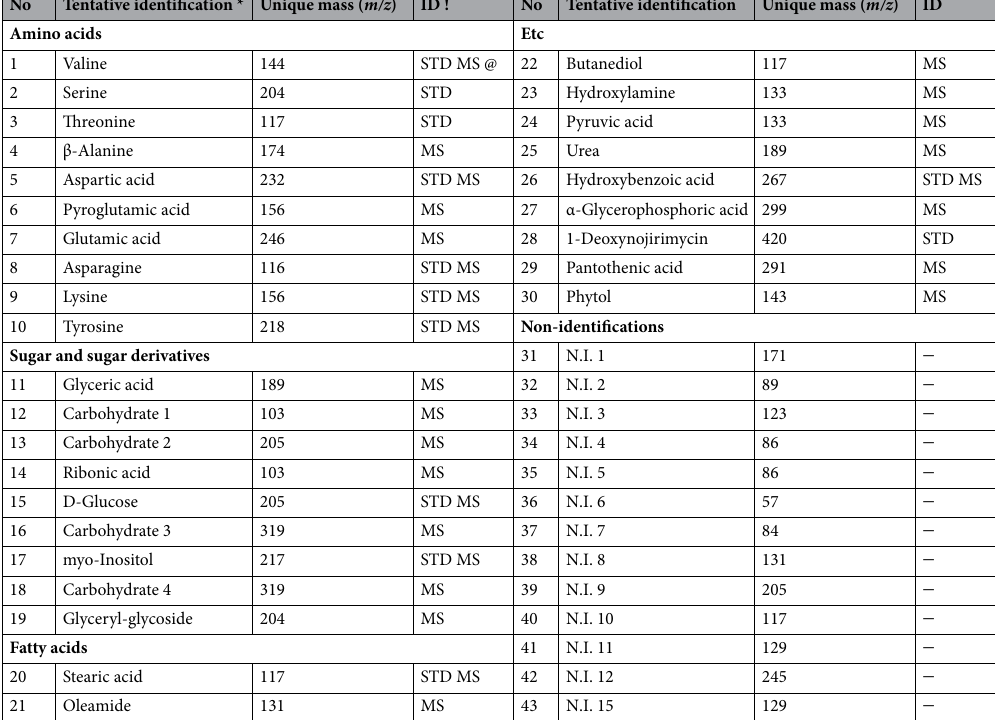
Table 2. Metabolites identified in a silkworm powder (SW). *Tentative metabolites based on variable important projection (VIP) analysis with a cutoff value of 0.7 and p-value < 0.05; ! Identification: STD, Standard @MS fragment patterns